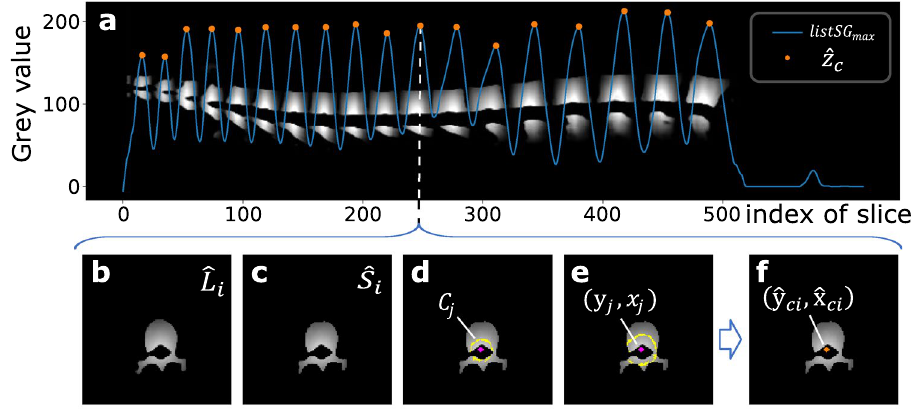
Figure 4. Aggregating method to estimate vertebra centroid.